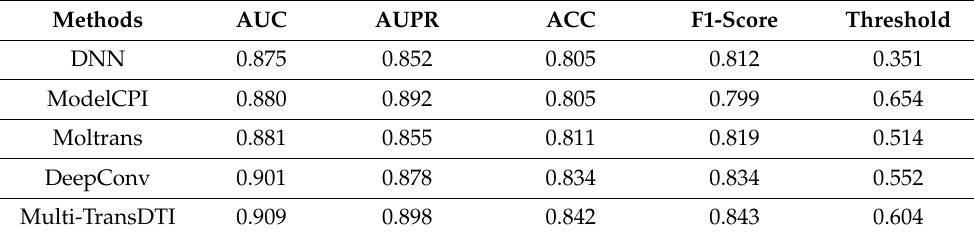
Table 3. Comprehensive performance of different models on 100% BindingDB.